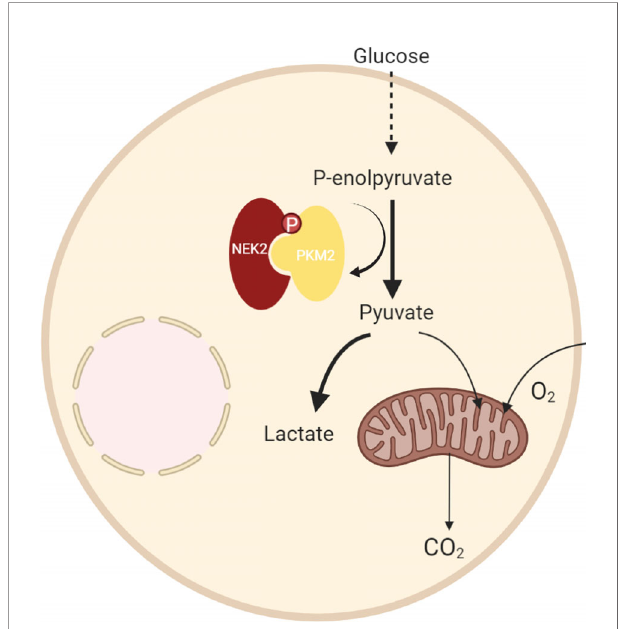
FIGURE 8 | A proposed model to illustrate the regulation of DLBCL by NEK2 through